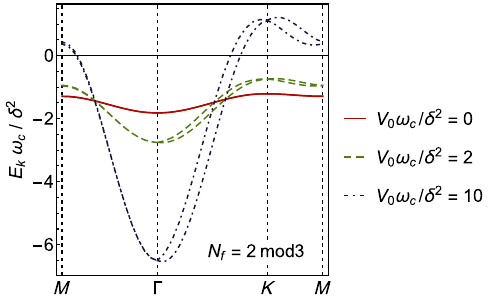
10. Band structure for different values of V 0 ω c = δ 2 for 2 mod 3 . In this case E = δ 2 is just a function of V N f ¼ k Qualitatively, the shape of the band structure does not change significantly upon increasing V 0 ω c = δ 2 ; the quantitative changes can be significant, though. For high V 0 ω c = δ 2 , the band structure becomes independent of N f